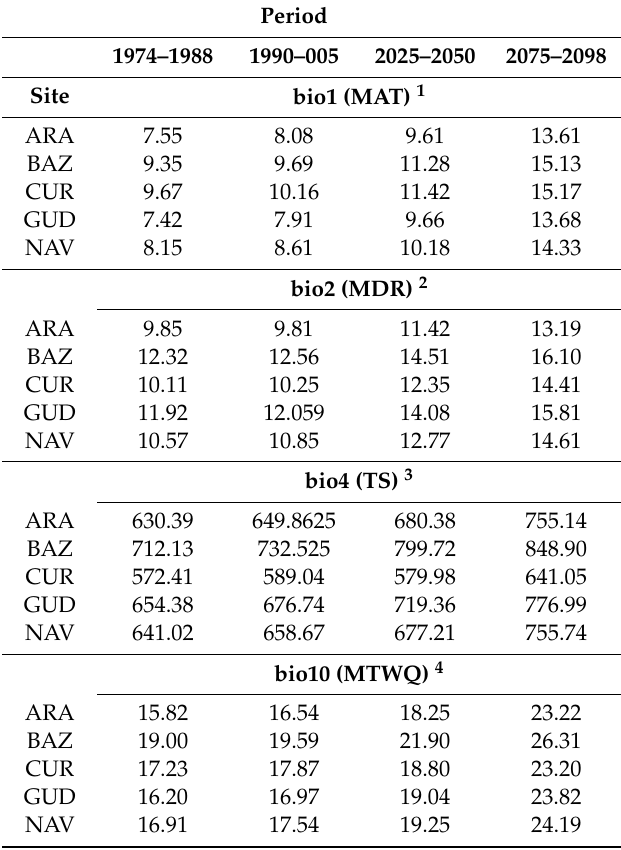
Table A1. Mean of the climatic indices for the di ff erent periods considered in the study for the location of the provenance test